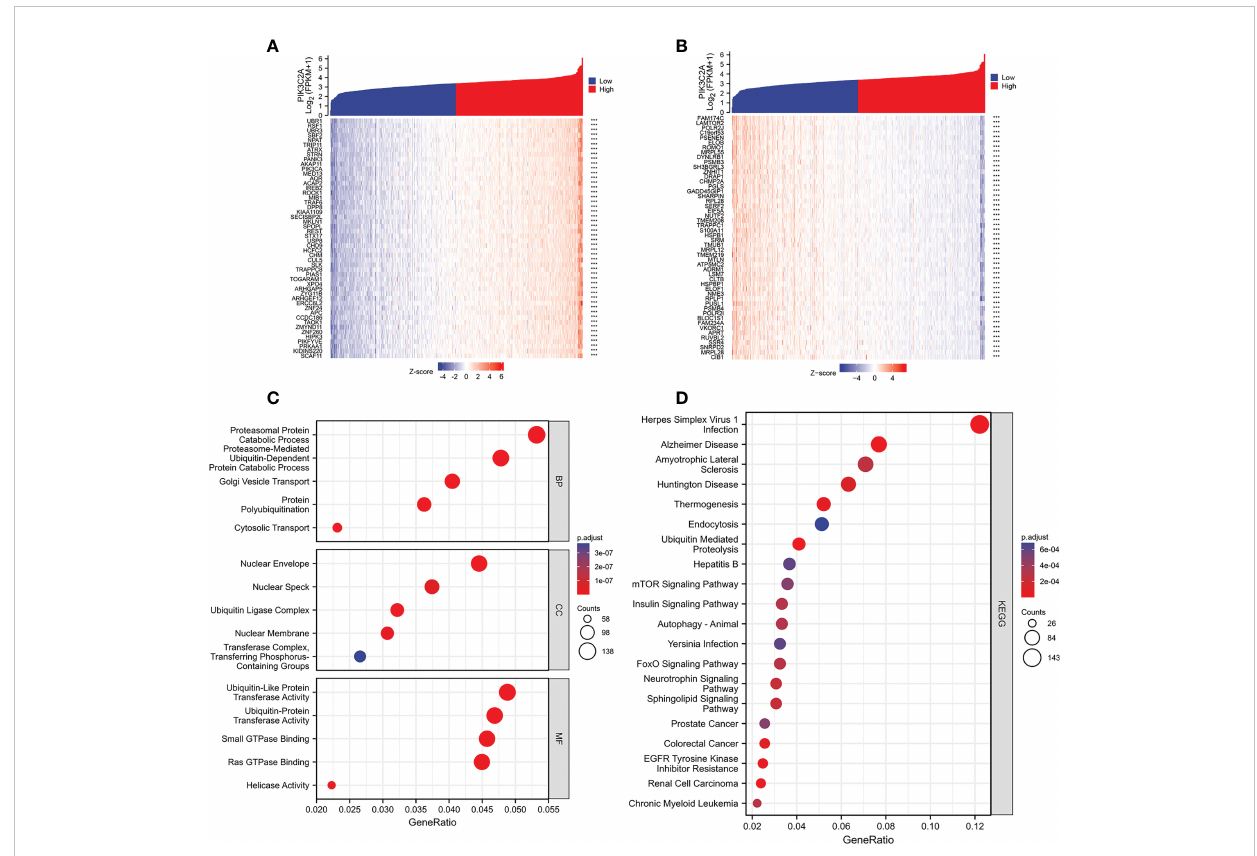
FIGURE 8 Functional enrichment analysis of the PCGs associated with PIK3C2A. (A) The heatmap exhibits the top 50 genes positively related to PIK3C2A. (B) The heatmap indicates the top 50 genes negatively associated with PIK3C2A. (C, D) The bubble charts visualize the results of GO term and KEGG pathway enrichment analysis of the PCGs co-expressed with